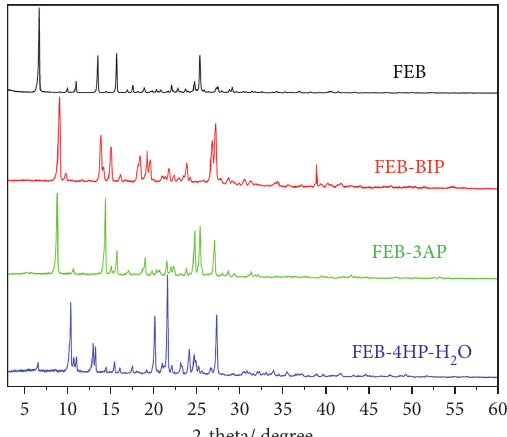
Figure 8: PXRD pattern of FEB (black), FEB-BIP cocrystal (red), FEB-3AP salt (green), and FEB-4HP-H